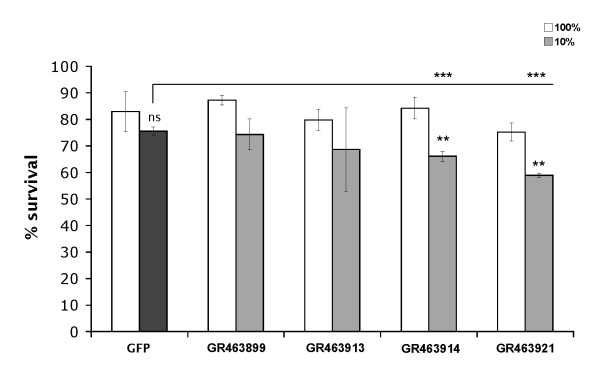
Cross-species RNAi using A. avenae EST sequences to induce gene silencing in P. superbus. P. superbus larvae were subjected to RNAi for 11-13 days with selected A. avenae genes (GR463899, ggr-3; GR463913, col-14; GR463914, glutathione peroxidase; and GR463921, novel) identified in a preliminary screen. GFP was taken as a negative control for RNAi. The resulting mixed stage worms were subjected to desiccation at 10% RH for 24 h (negative control - black bar; other samples - grey bars). All samples were also subjected to mock desiccation at 100% RH (white bars). Mean values of triplicates, together with standard deviations, are shown; a one-way ANOVA with Tukey post-hoc test was performed on GR463914 and GR463921: *, significance at P < 0.05; **, significance at P < 0.01; ***, significance at P < 0.001; ns, not significant.